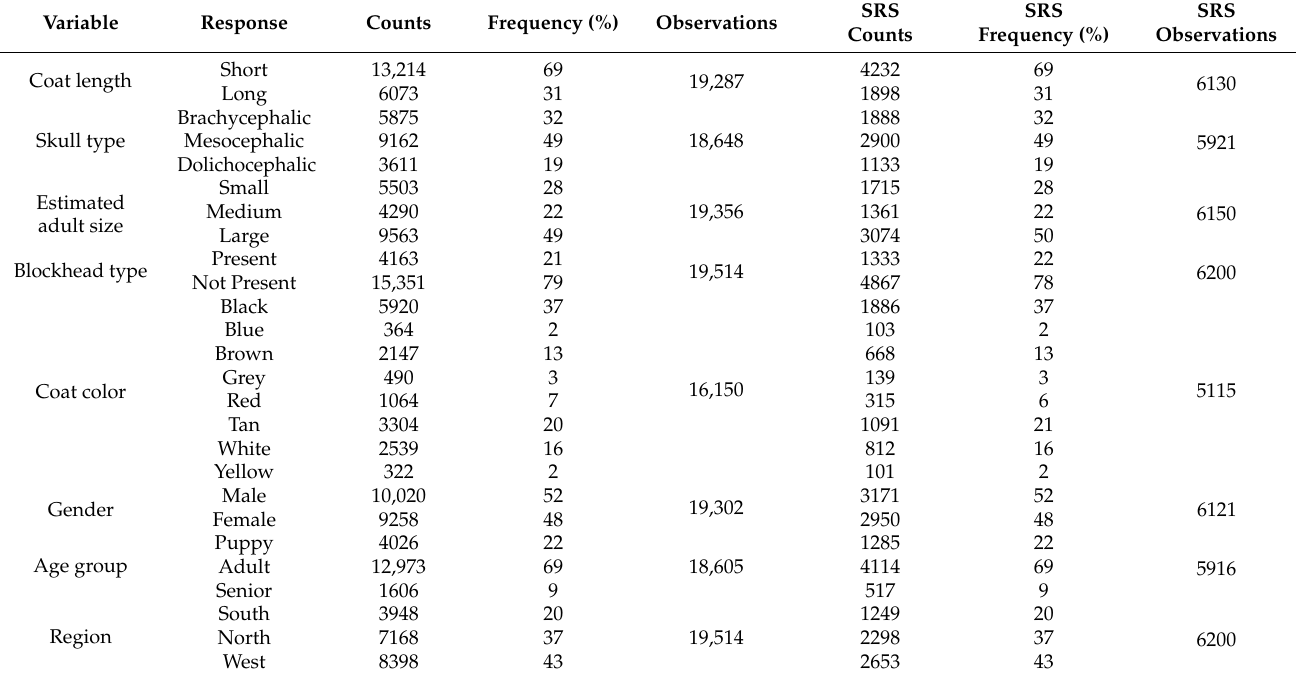
Table 1. Frequencies of phenotypes tested for multivariate euthanasia model inclusion using the full dataset 19,514 shelter dogs and the simple random sample (SRS) of 6200 dogs.